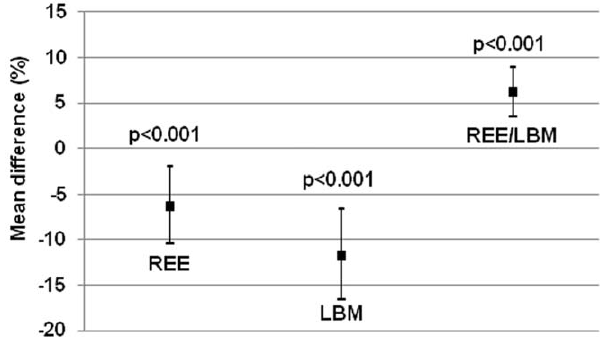
Figure 2. Mean difference between VLBW and term born young adults: linear regression models . Mean difference in percent in resting energy expenditure (REE), lean body mass (LBM) and the proportion of REE to LBM (REE/LBM) between the very low birth weight (VLBW) (error bars showing 95% confidence intervals) and control groups (zero line) in linear regression model adjusted for age and sex.